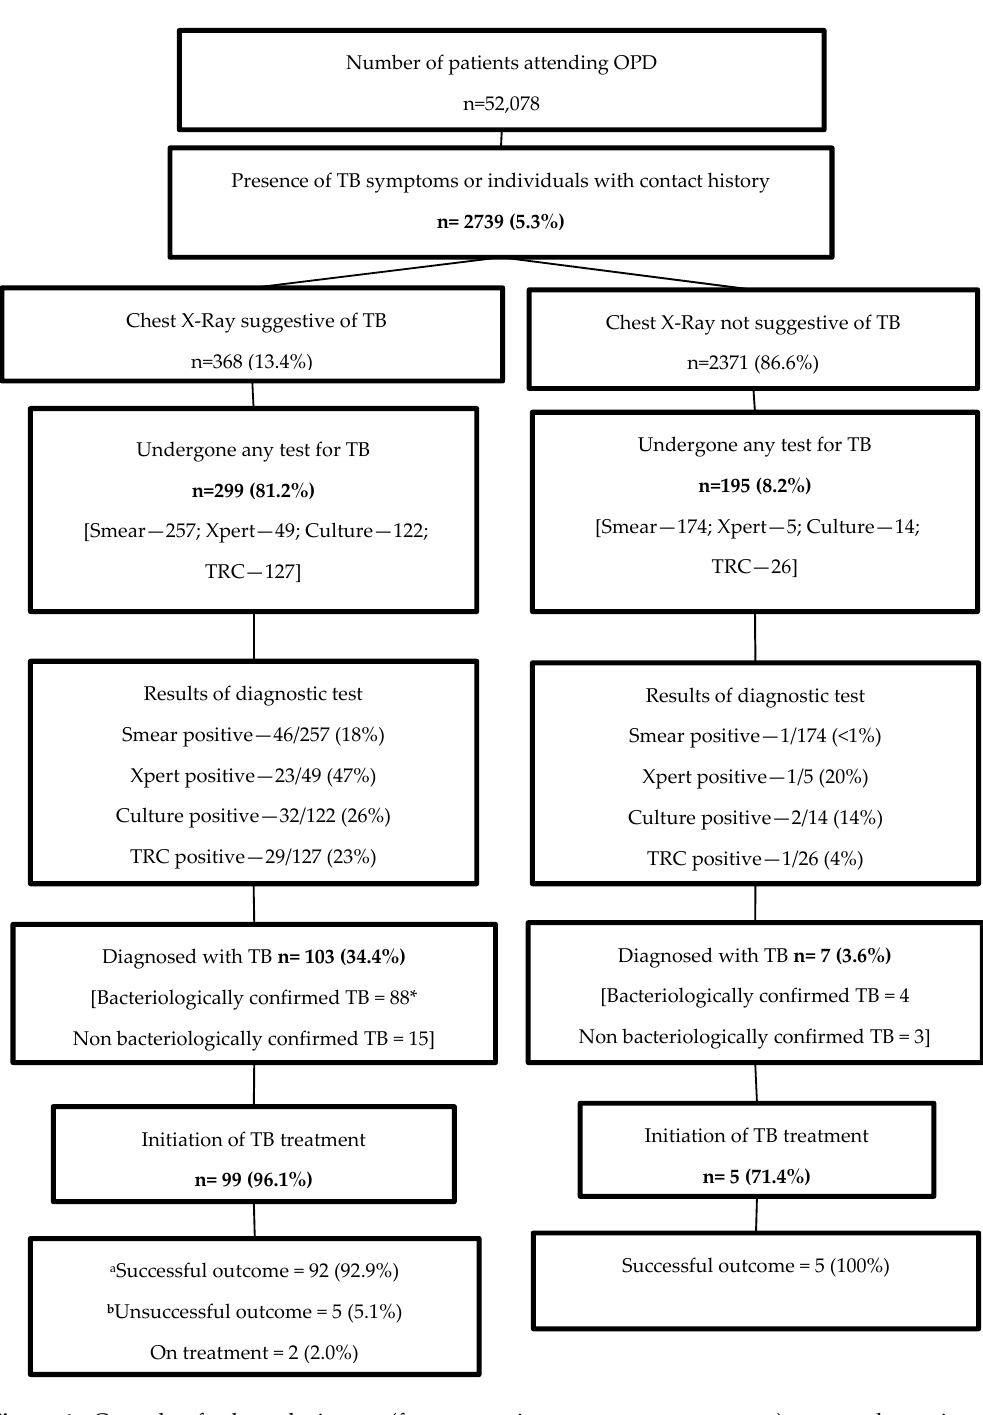
Figure 1. Cascade of tuberculosis care (from screening to treatment outcome) among the patients attending the Haiphong International General Hospital in Vietnam, from June to December 2018. OPD = Outpatient Department; TB = tuberculosis; TRC = transcription concerted reaction. a: successful outcome: cured and treatment completed. B: unsuccessful outcome: death, loss to follow-up, failure, and not evaluated. *Two individuals had rifampicin resistance and were started on second-line drugs.